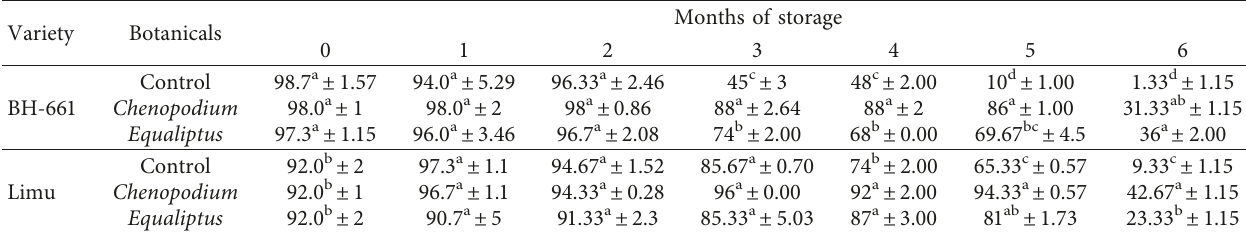
Table 2: Effect of botanicals and variety on germination capacity (mean ± SD) of maize. Variety